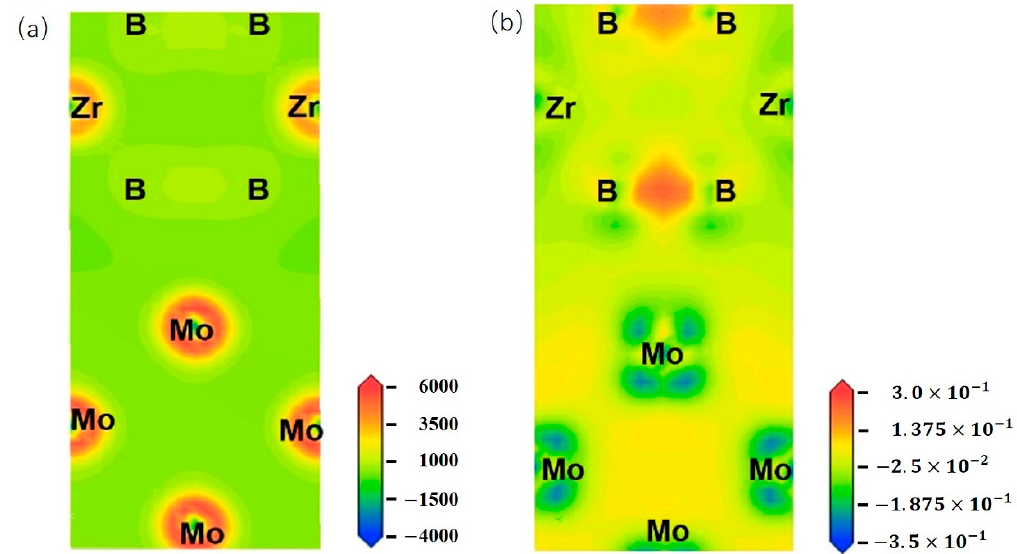
Figure 11. Distribution of ( a ) charge density and ( b ) charge density difference along the (110) direction for the ZrB 2 /Mo interface in Model 2.